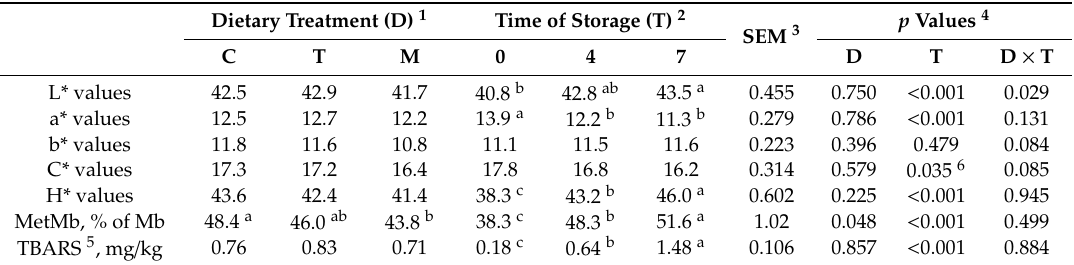
Table 3. E ff ect of the dietary treatment and time of storage on the oxidative stability parameters of meat. Dietary Treatment (D)